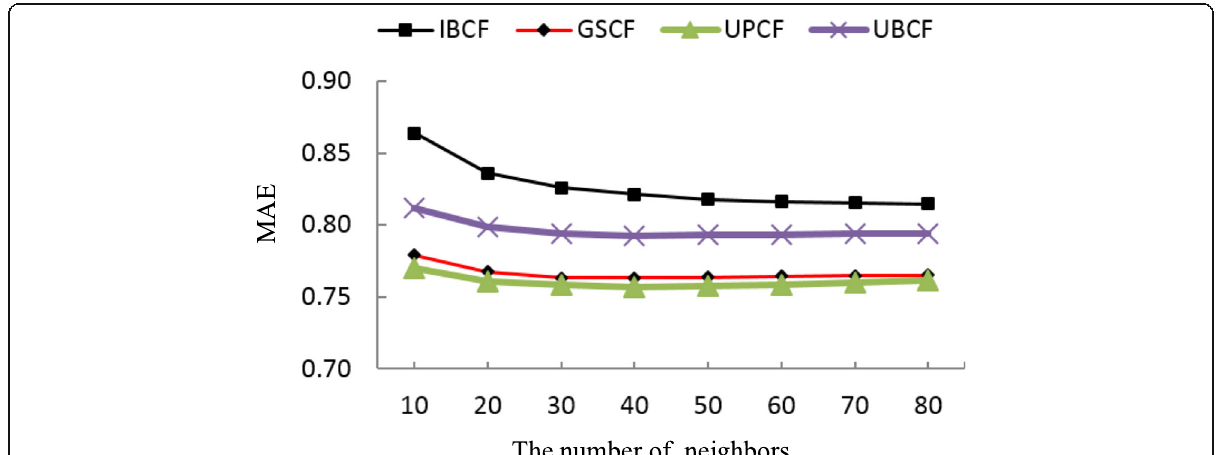
Fig. 6 The comparison of the MAE values between four algorithms in data set of train2. The MAE value of the three algorithms decreases first and then increases. When the nearest neighbor number is about 40, the MAE value is the smallest, which shows that the collaborative filtering algorithm is affected by the nearest neighbor number. When the nearest neighbor number is the same, the MAE of UPCF algorithm is the smallest, that is, the predicted score is close to the real value of the user and it provides the best recommendation result. It fully illustrates the importance of the user to the subjective behavior of the commodity score